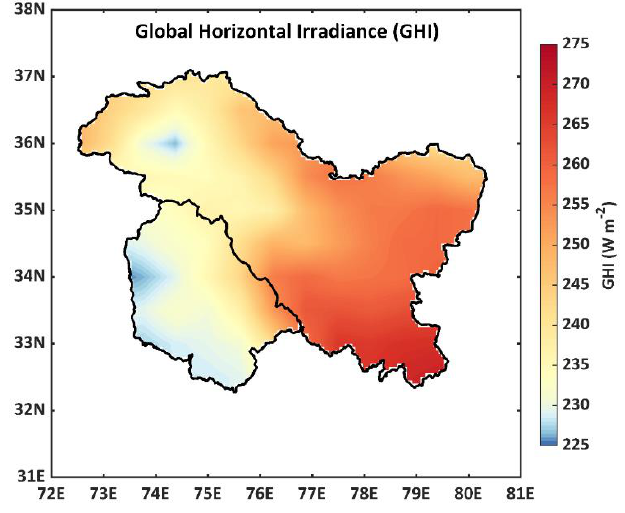
Figure 5. Spatial variation of yearly averaged GHI from 1981 to